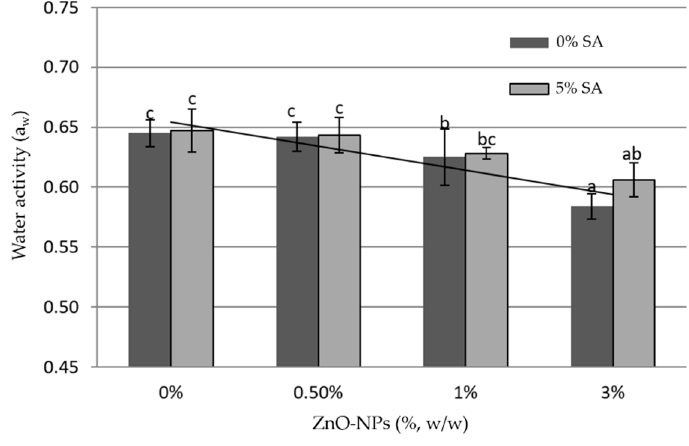
Figure 4. Water activity of biohybrid nanocomposite films (the error bars represent standard deviation and bars with different letters are significantly different based on Duncan’s multiple range test with α = 0.05) .